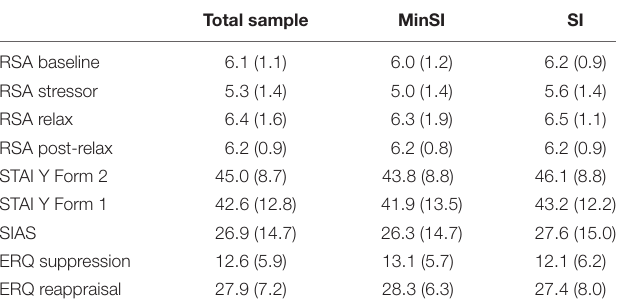
TABLE 1 | Means ( ± SD) for total sample in MinSI and SI groups.